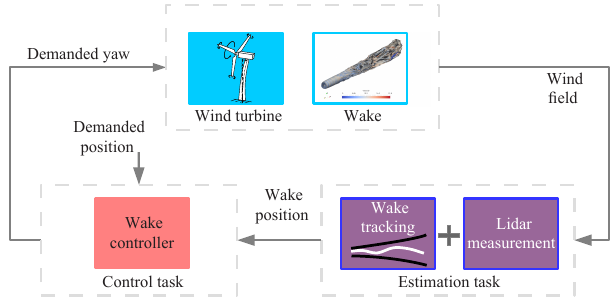
Figure 1. The conceptual diagram of closed-loop wake redirection and its two main tasks: (1) the estimation task addressed in Sect. 5 and (2) the control task addressed in Sect.